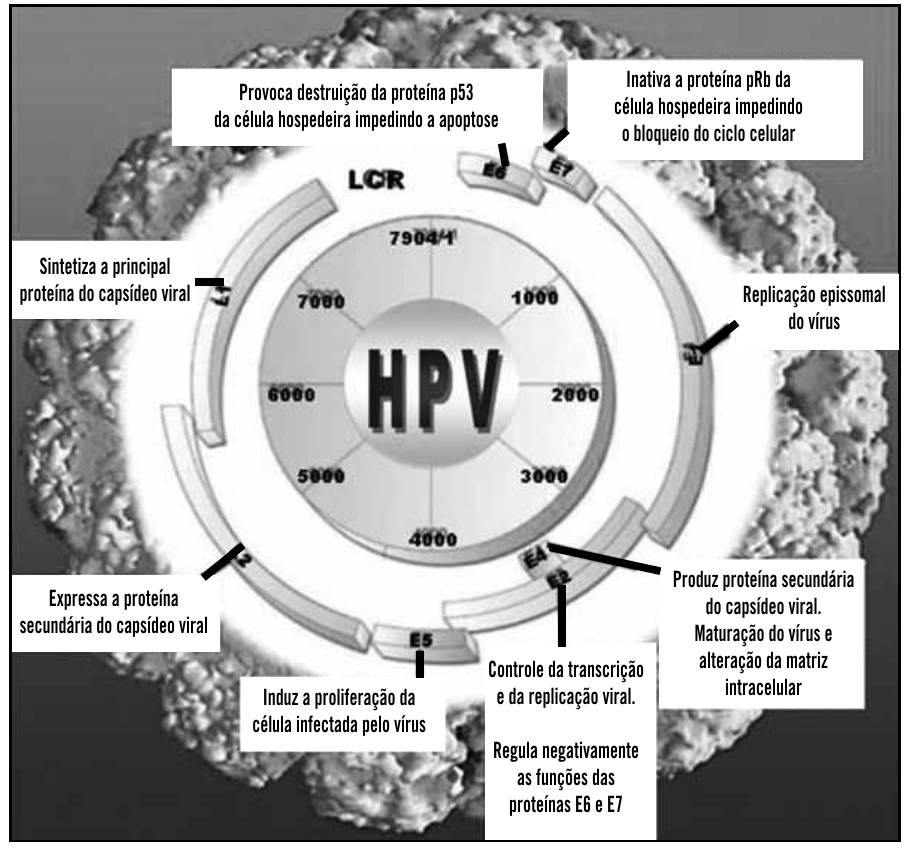
Figura 1 – Mapa genômico do HPV: importante no controle da replicação e da transcrição